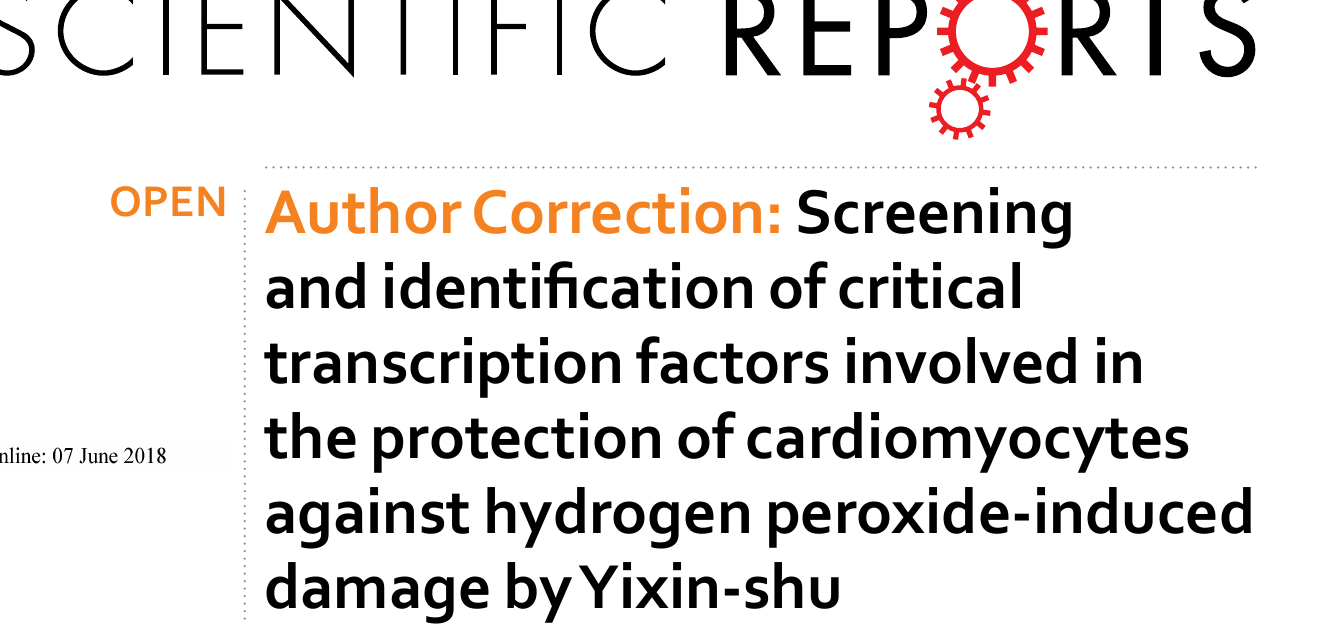
“Figure 4. The correlation between critical TFs and their target genes in response to H 2 O 2 -induced oxidative stress, based on the direction of TF regulation and the expression level of TFs’ target genes. Yellow nodes refer to activators; blue nodes refer to repressors. Panel (A) reprinted from [1] with